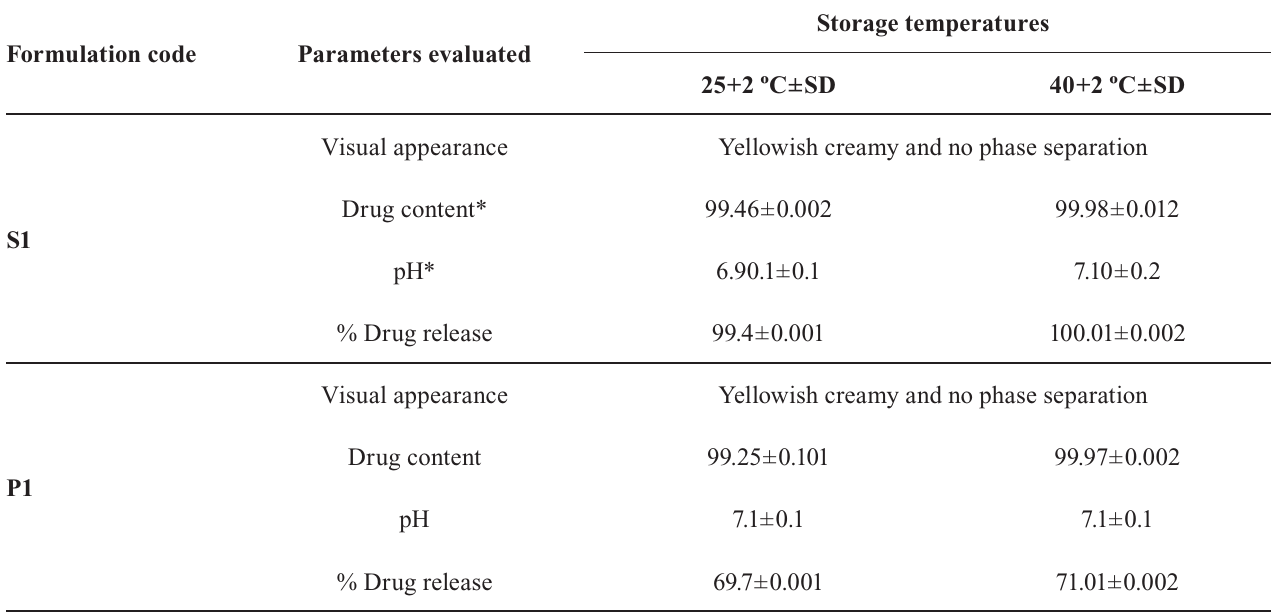
TABLE VIII - Stability studies of optimized formulations S1 and P1